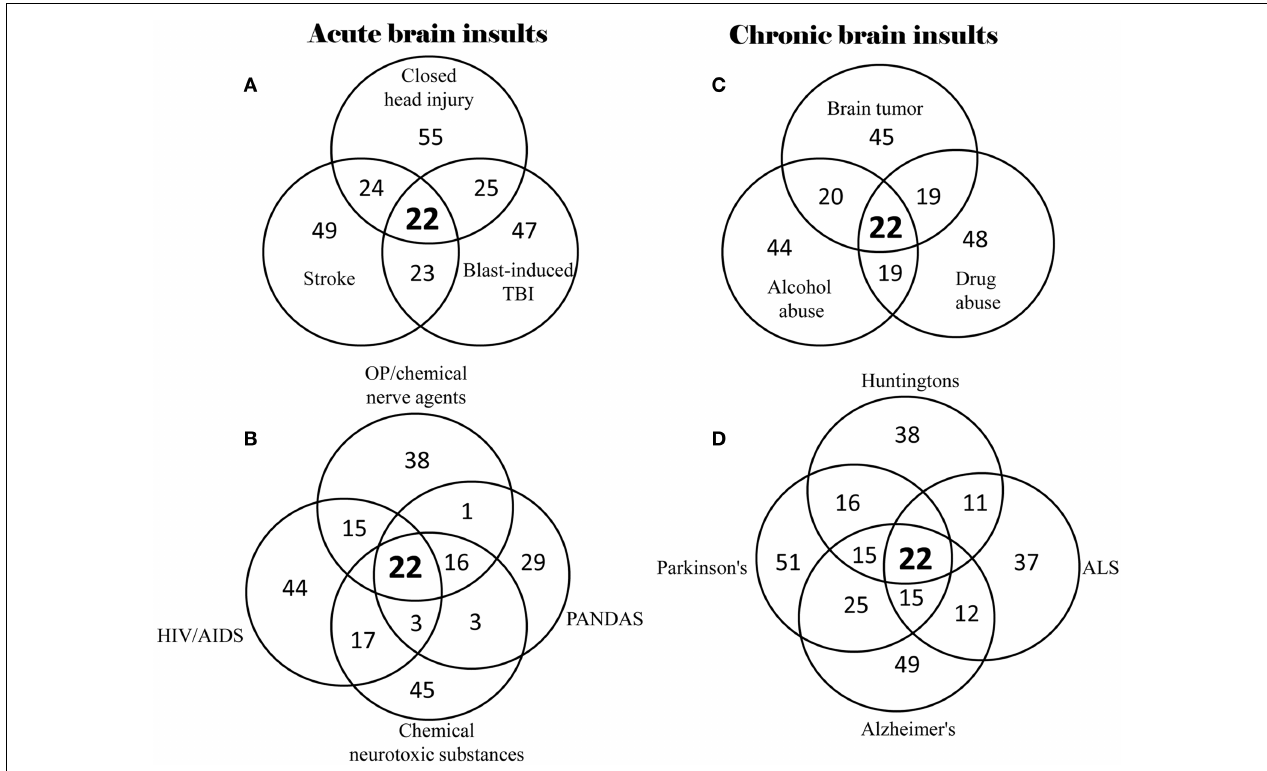
substances, HIV/AIDS, and PANDAS; (C) Overlap of symptom clusters among brain tumor, alcohol abuse, and drug abuse; and (D) Overlap of symptom clusters among Parkinson’s disease, Alzheimer’s disease, ALS and Huntington’s